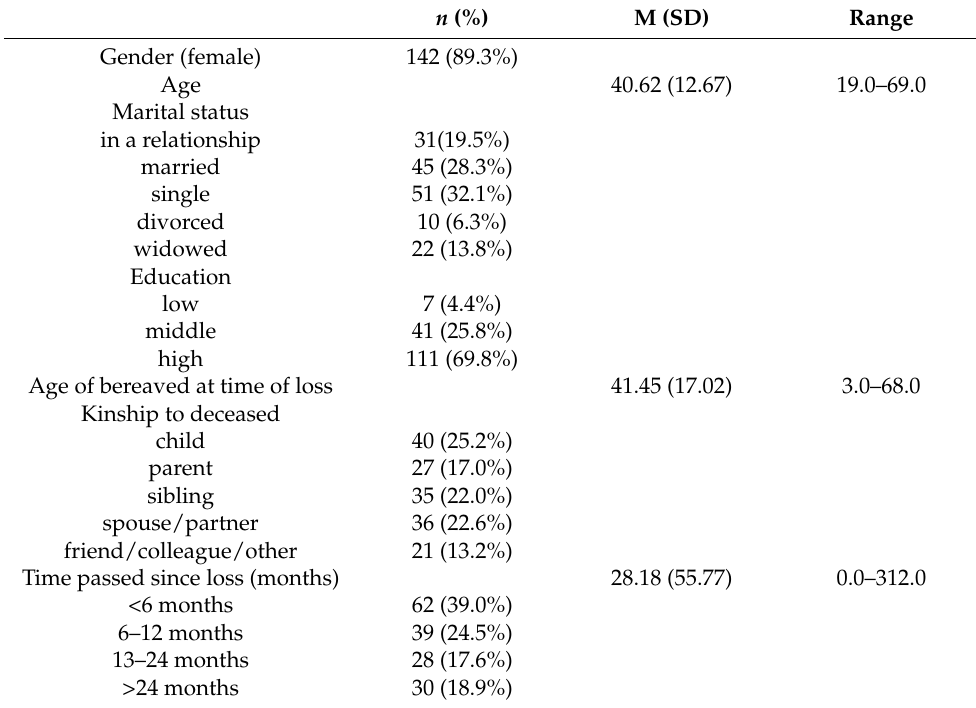
Table 2. Sociodemographic and loss-related characteristics of the